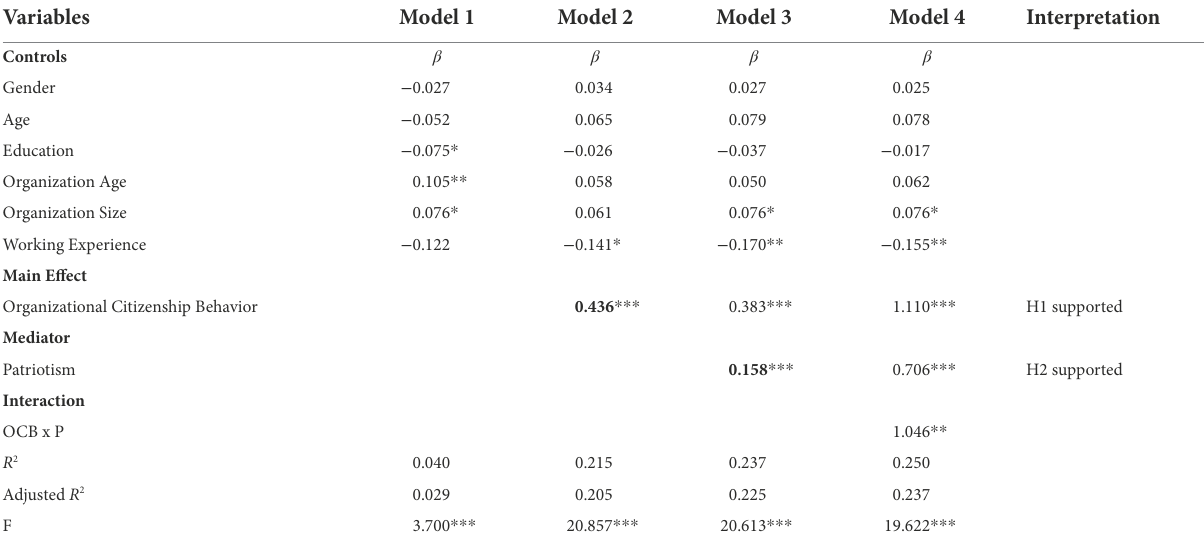
TABLE 5 Hierarchical linear regression.